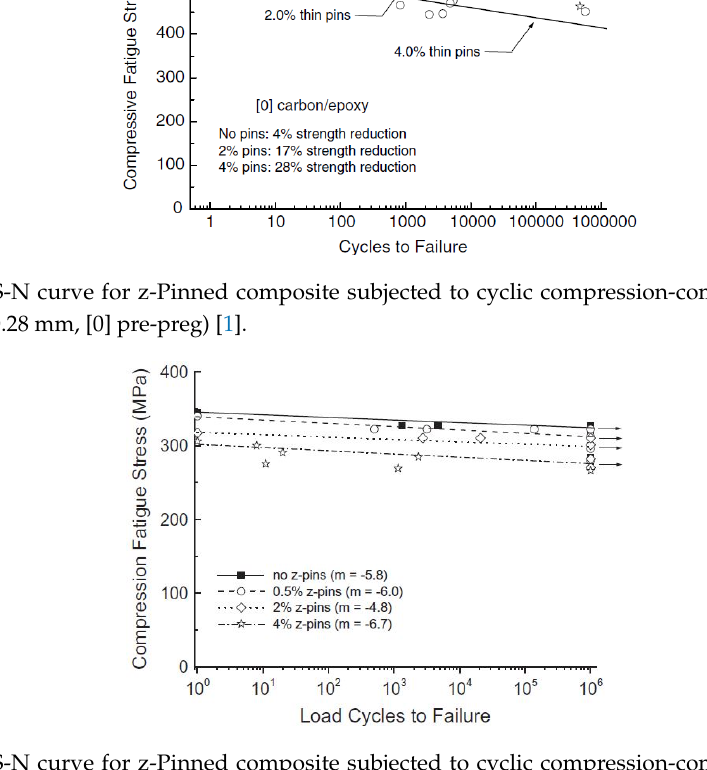
Figure 49. S-N curve for z-Pinned composite subjected to cyclic compression-compression (CFRP z-Pins, d = 0.28 mm, [0 / ± 45 / 90] pre-preg)